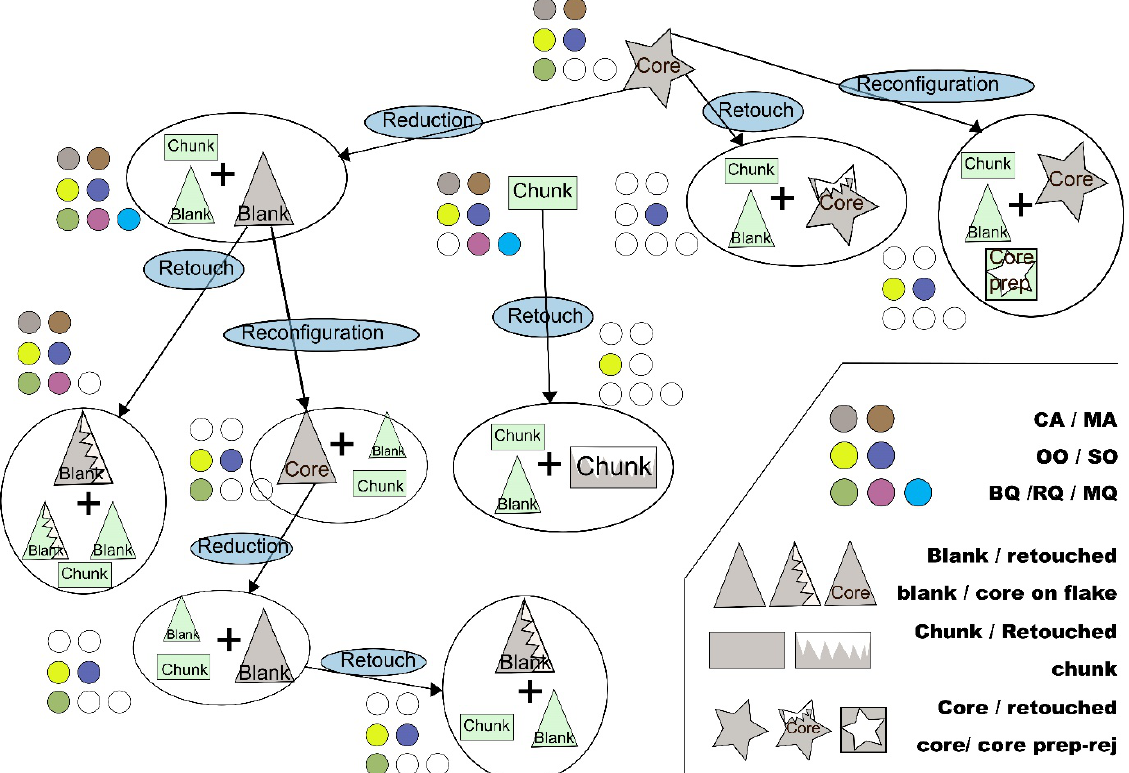
Figure 9. Schematic and basic reduction sequence derived from the analysis of the Level XXII-R from El Esquilleu. Highlighted in colours and associated to each process are the types of quartzites